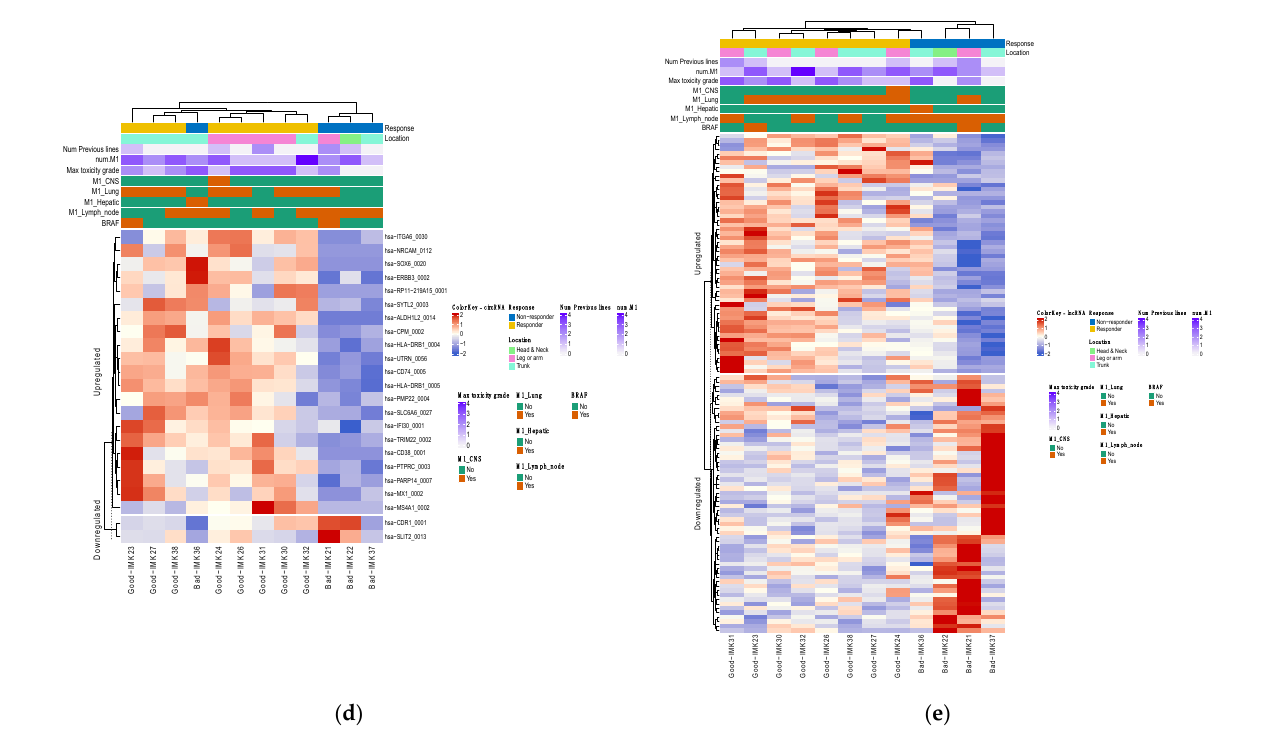
Figure 3. CeRNAs as biomarkers of response to ICB in metastatic melanoma. ( a ) Volcano plot with 23 circRNAs that are differentially expressed ( b ) Volcano plot with 112 lncRNAs that are differentially expressed ( c ) Ratio of circRNA vs. lineal RNA per differentially expressed circRNA loci. Y-axis lists the differentially expressed circRNA among responders and non-responders. X-axis represents ratio: 2*circular/(2*circular + linear), where range 0 represents deviation to linear expression and 1 maximum deviation to circRNA expression. ( d , e ) Expression signatures of the differentially expressed circRNAs and differentially expressed lncRNAs, respectively, separate responders and non-responders to ICB. Normalized expression values are represented against location and several clinical variables.